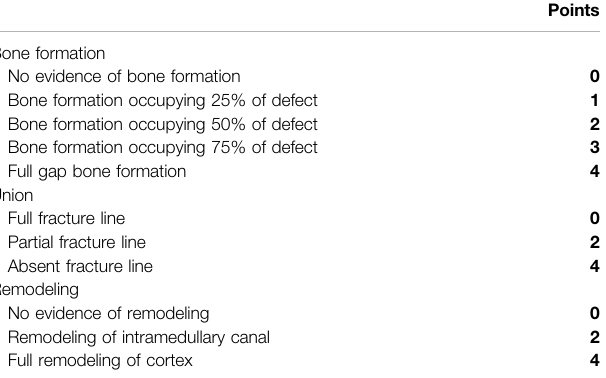
TABLE 1 | Lane-sandhu X-ray